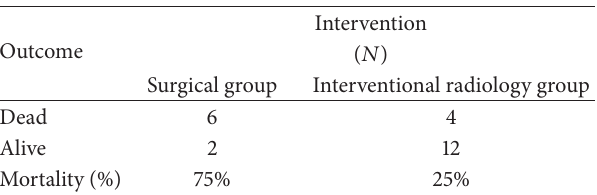
Table 5: Comparison of subjects’ 30-day outcome between surgical and interventional radiology